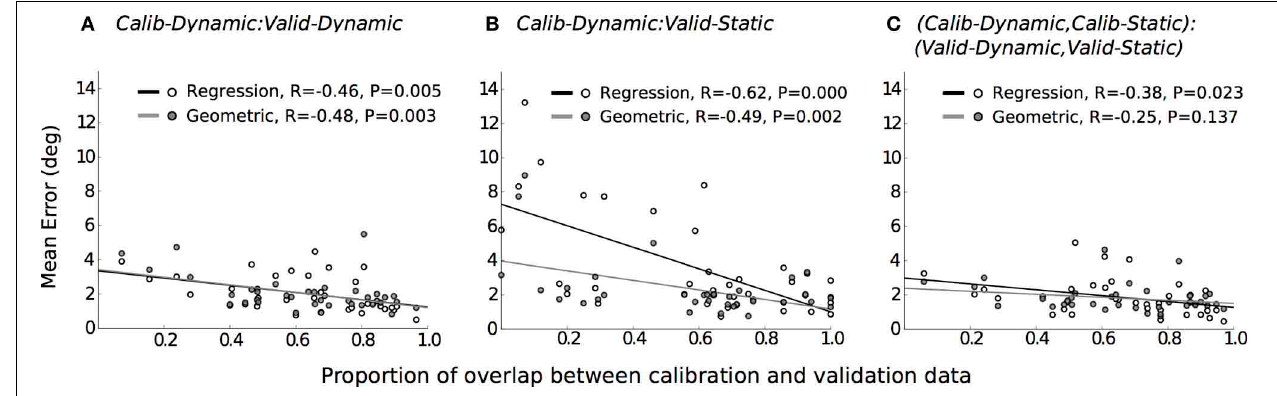
FIGURE 5 | The relationship between data overlap and mean gaze-tracking error for each evaluation, represented in separate panels. Each data-point depicts the mean error and its corresponding data overlap for the regression ( ) and geometric method ( ). The lines of best fit are plotted